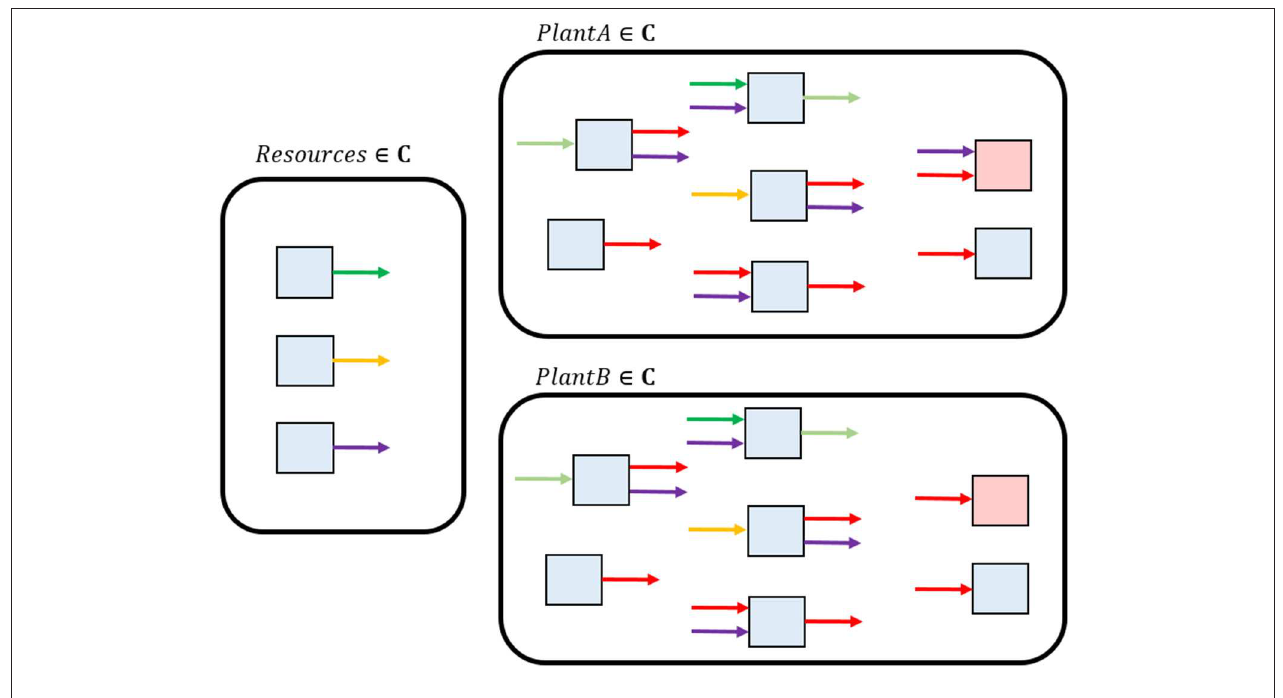
FIGURE 3 | Example of cluster